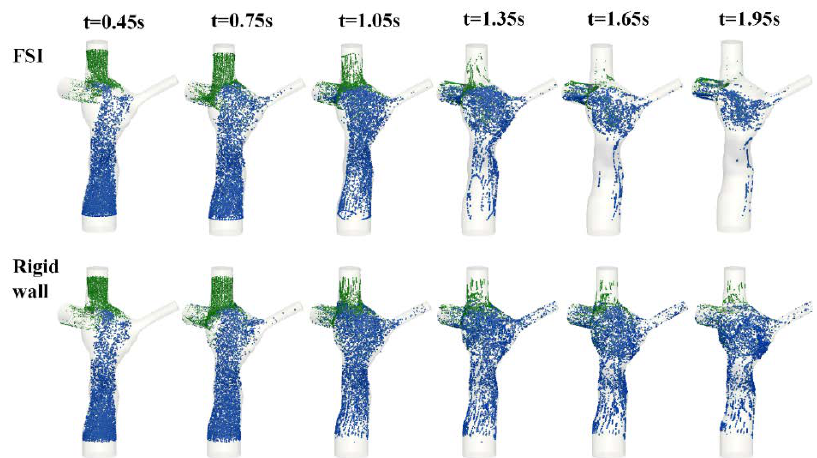
Figure 14. Screenshots of the particle tracking results of fluid-structure interaction (FSI) and rigid wall simulations from t = 0.45 s to t = 1.95 s. Particles originating from the FP are colored blue, and particles originating from the SVC are colored green. FP: Fontan pathway.